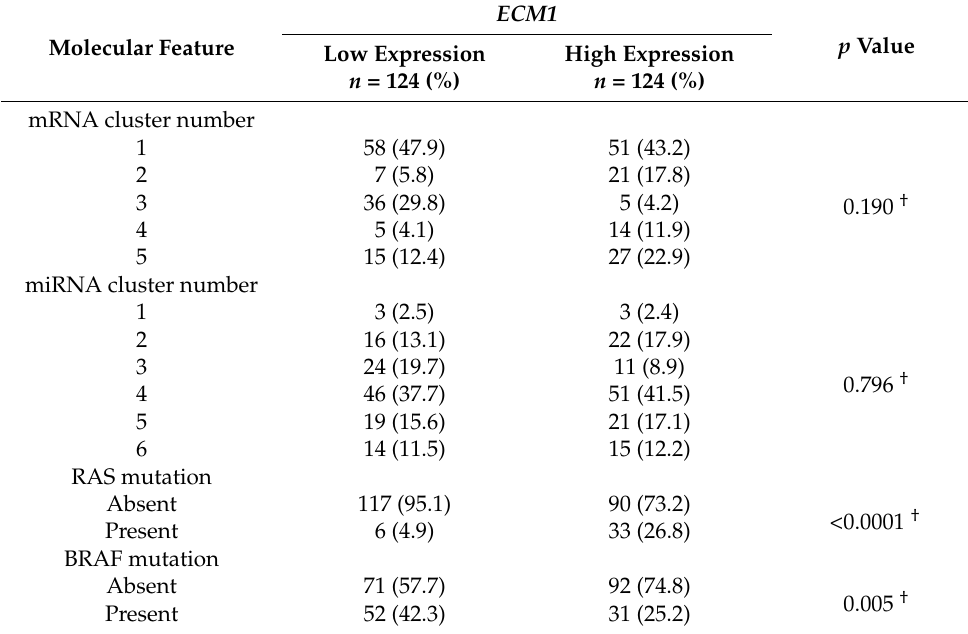
Table 2. Molecular features of TCGA THCA according to ECM1 expression